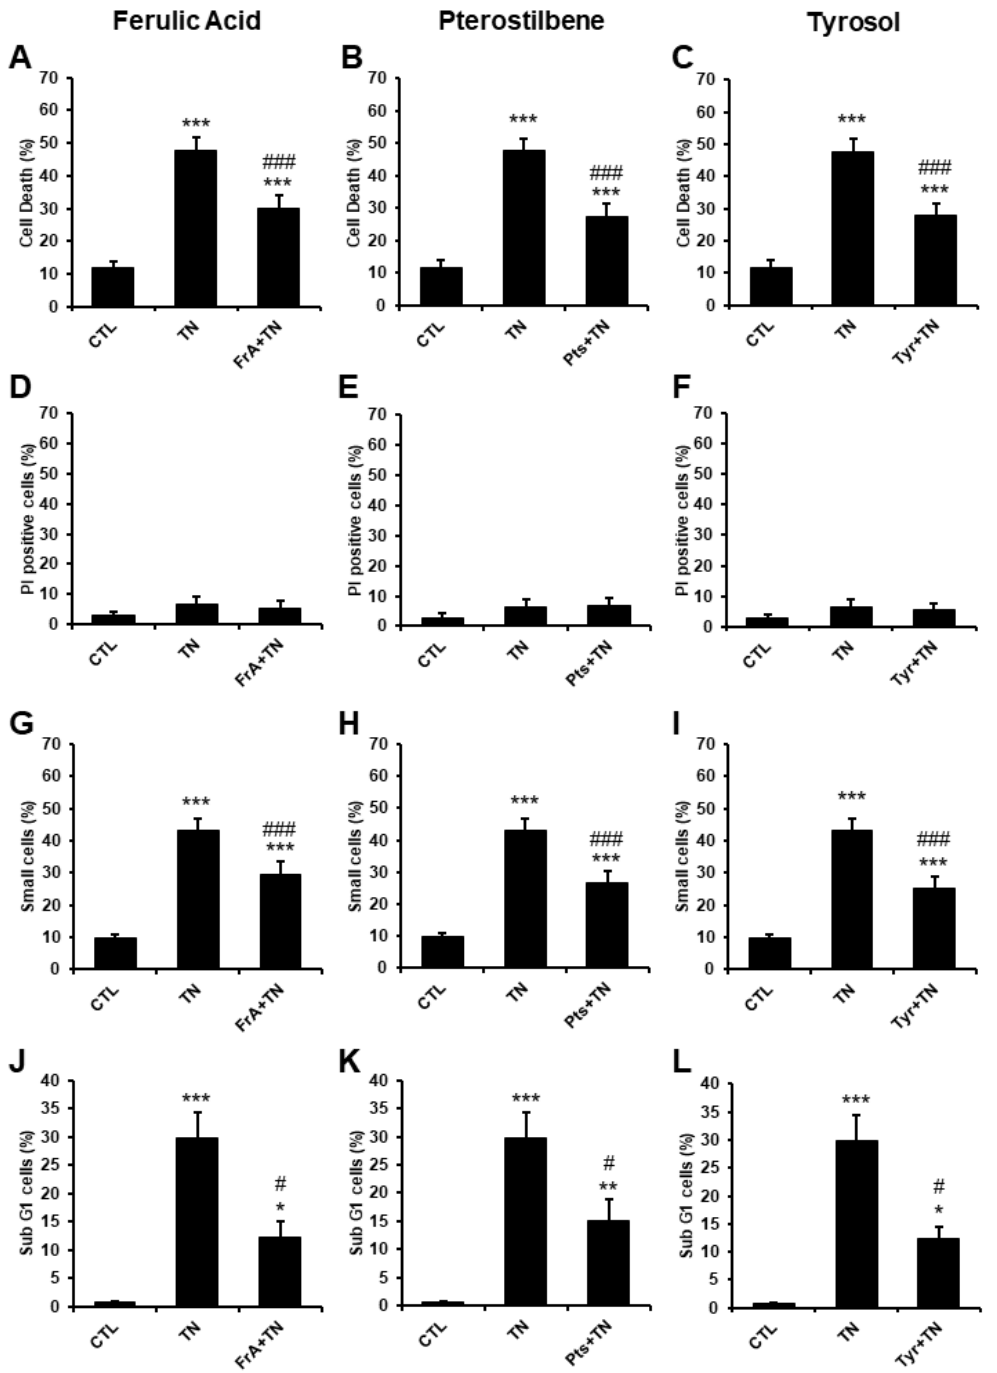
Figure 5. Ferulic acid, pterostilbene, and tyrosol protect cardiac cells from apoptosis induced by severe ER stress. H9c2 cells were pre-treated for 1 h with ferulic acid (FrA, 5 µ M), pterostilbene (Pts, 0.5 µ M), or tyrosol (Tyr, 1 µ M), and then incubated for 48 h with tunicamycin (10 µ g/mL). Cell death was analyzed by flow cytometry using FDA assay ( A – C , n = 12). FDA is cleaved into green fluorescein by intracellular esterases present in living cells. All non-FDA-fluorescing cells are considered dead. The percentages of dead cells are presented (Cell death (%)). Necrosis was evaluated by measuring plasma membrane permeability by flow cytometry using propidium iodide ( D – F , n = 3). Apoptosis was analyzed by flow cytometry by measuring cell shrinkage (small cells) ( G – I , n = 12) and DNA fragmentation (Sub G1 cell population) ( J – L , n = 4). Values represent mean ± S.E.M. * p < 0.05, ** p < 0.01, *** p < 0.001 vs. control; # p < 0.05, ### p < 0.001 vs.